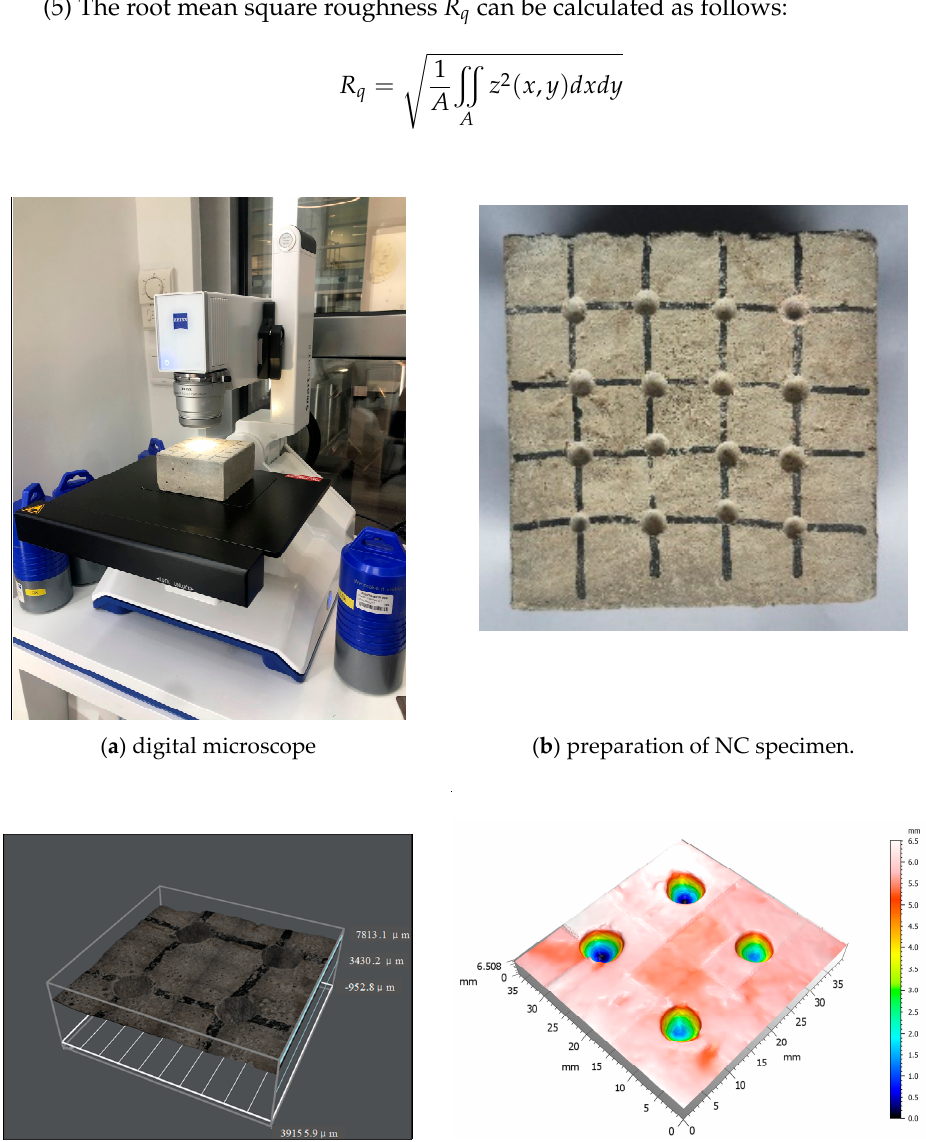
Figure 2. Scanning of the treatment interface.